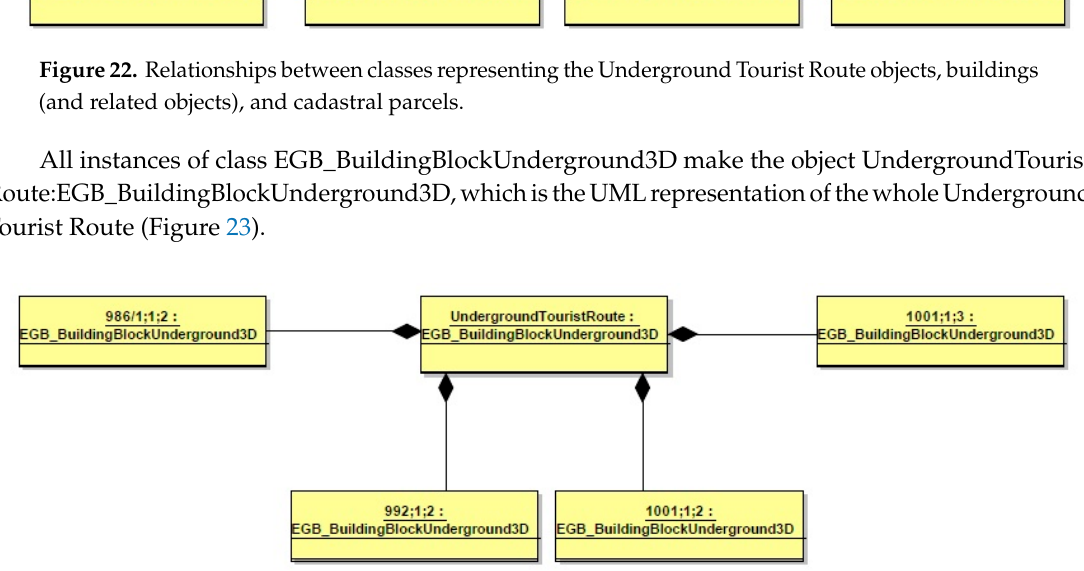
Figure 23. UML schema of objects making the Underground Tourist Route.